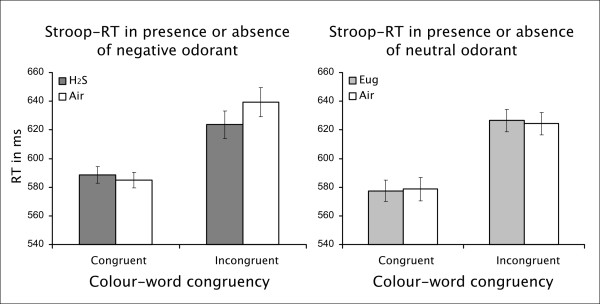
Stroop Reaction Time Results. Mean reaction times (and standard error of the mean, after normalisation for subject effects) for conditions of the H2S run (left) and Eugenol run (right). In the left panel it is shown that the negative odorant only influenced the reactions time to incongruent stimuli (p = .031), leading to a reduced Stroop effect. Eugenol showed no effect on the measured response times. Note the apparent difference between incongruent trials in the 'air' blocks of both runs, which was not statistically significant (p = .343), however.